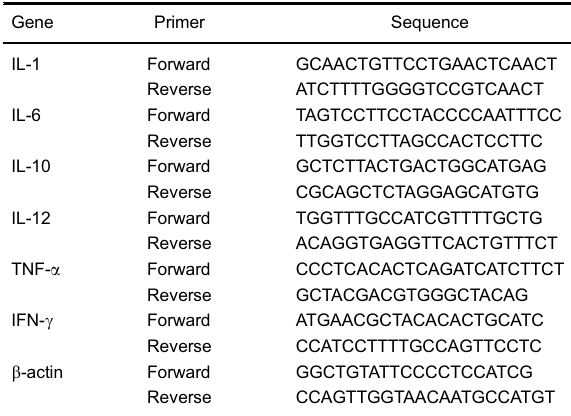
Table 1. Primer sequence used in the